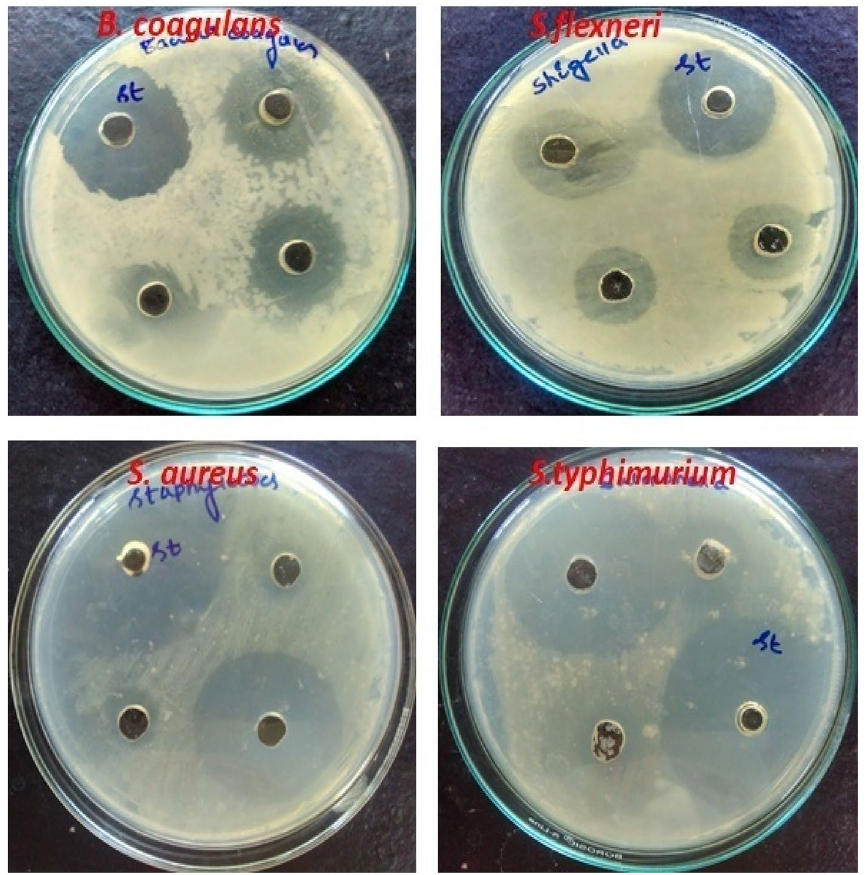
Figure 14. Antimicrobial activity of TANI/Cu 2 O/Ag NC.